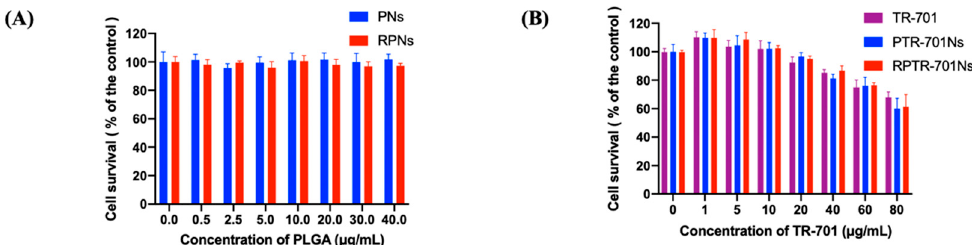
Figure 6. Cell survival ratio of HEK 293 cells after treated with; ( A ) nanoparticle material; and ( B ) drug loading nanoparticles with different concentration for 24 h. Data were presented as the mean ± SD ( n = 6).